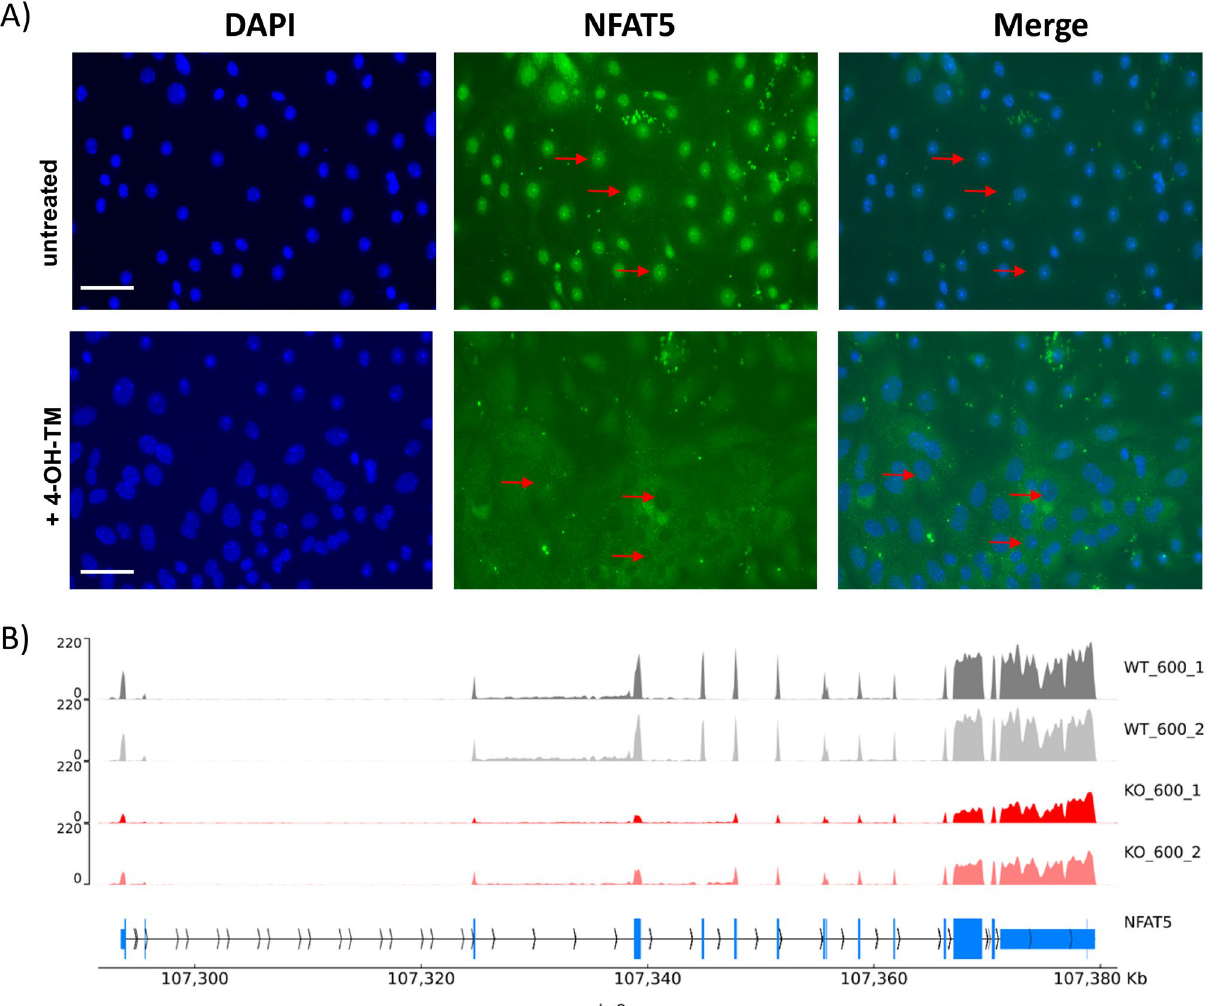
The cells were either left untreated (upper panel) or treated for 24 h with 4-hydroxytamoxifen. After 3 days of additional cultivation, the expression of NFAT5 was analyzed by immunofluorescence using an NFAT5 specific antibody and an Alexa-488 labeled secondary antibody. DAPI was used to stain the nucleus. In untreated cells NFAT5 can be clearly observed in cell nuclei, whereas nuclear labeling is absent in cells treated with 4-Hydroxytamoxifen. Red arrows mark positive and negative NFAT5 nuclei. ( B ) Mapping of the reads from the RNA-seq to the Nfat5 gene locus using the IGV shows effective deletion of exon